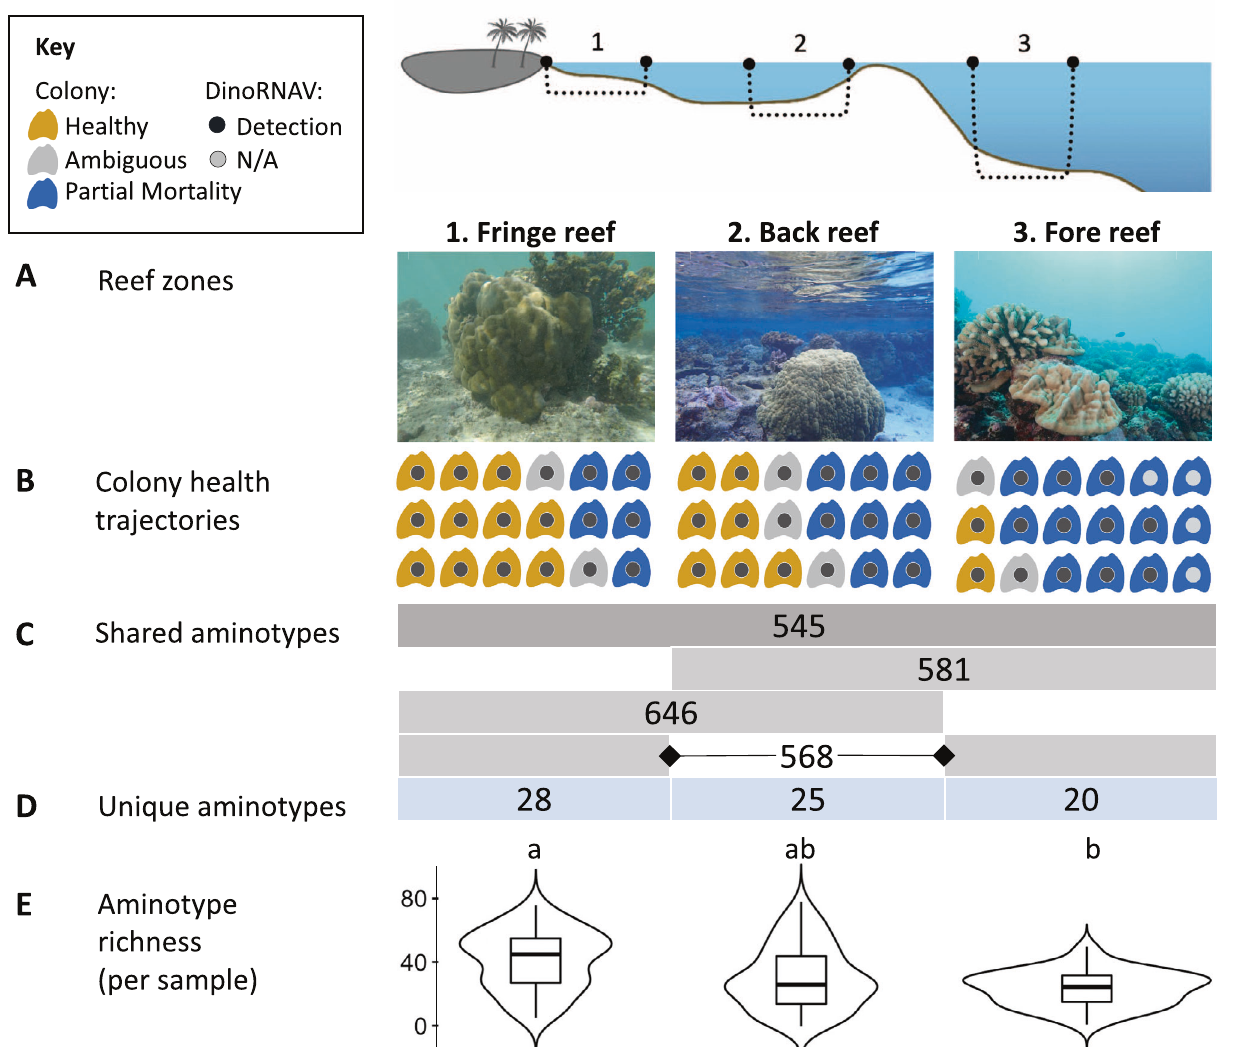
Fig. 1 Sampling overview and dinoRNAV detection summary from Porites lobata colonies on the reefs of Moorea, French Polynesia (South Paci fi c). A Schematic cross section of sampled reef zones and representative images of focal Porites lobata coral colonies in each reef environment. Eighteen colonies per reef zone were tagged and sampled four times from August 2018 to October 2020. B Health trajectories of colonies between August 2018 and October 2020 based on image analysis. Orange icons represent colonies that remained visually healthy throughout the sampling duration, whereas blue icons indicate colonies that experienced partial mortality. Gray icons indicate colonies for which health trajectory was ambiguous based on the images available. Dark gray center dots indicate dinoRNAV detection. Light gray “ N/A ” dots indicates that a colony that was not sequenced due to poor RNA quality. C Number of unique dinoRNAV major capsid protein amino acid sequences ( ‘ aminotypes ’ ) detected in samples from all three reef zones (darker gray) or in two of the three zones (lighter gray). D Number of aminotypes detected exclusively in colonies within a given reef zone. E Boxplot and width distribution of aminotype richness per colony. Letters indicate signi fi cant differences in dinoRNAV aminotype richness based on a pairwise Wilcoxon test with Bonferroni correction (fringe vs. back, p = 0.10; fringe vs. fore, p < 0.01; back vs. fore, p =